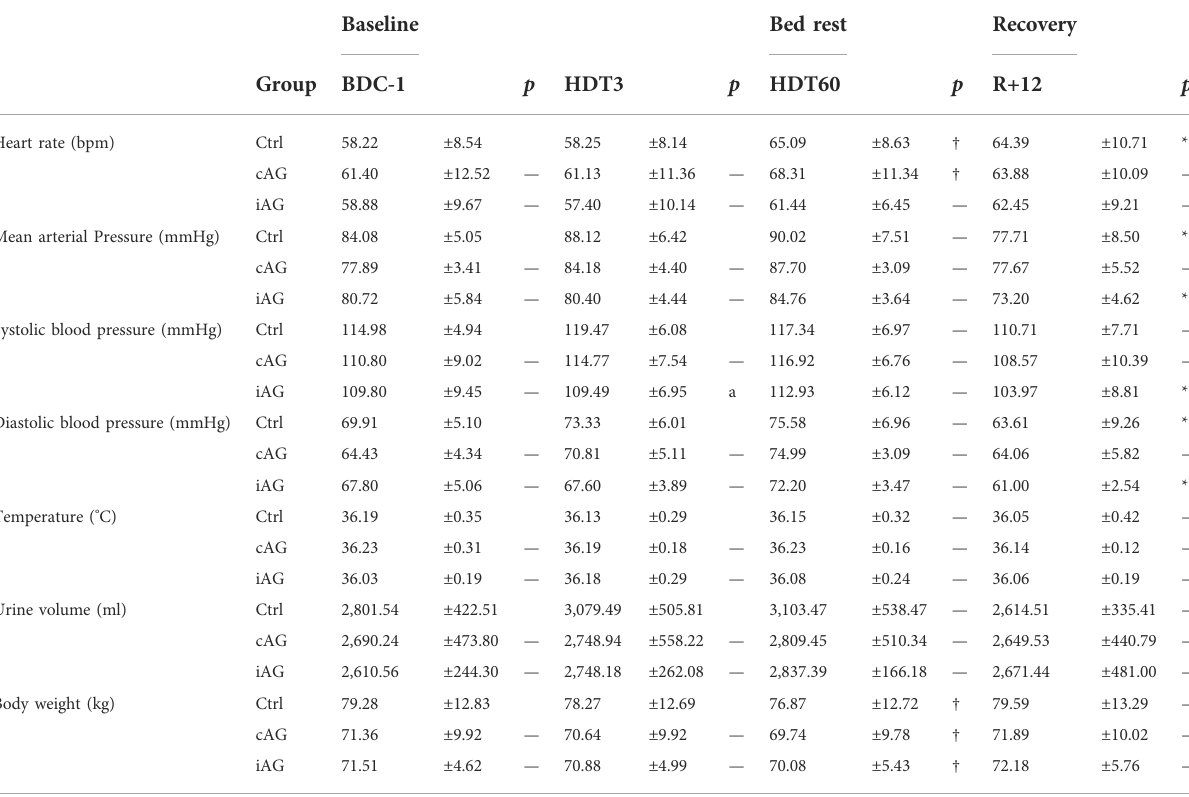
TABLE 5 Summary of the General Health Indices. Values were obtained through regression analysis and are presented for representative study dates as Mean ± SD.